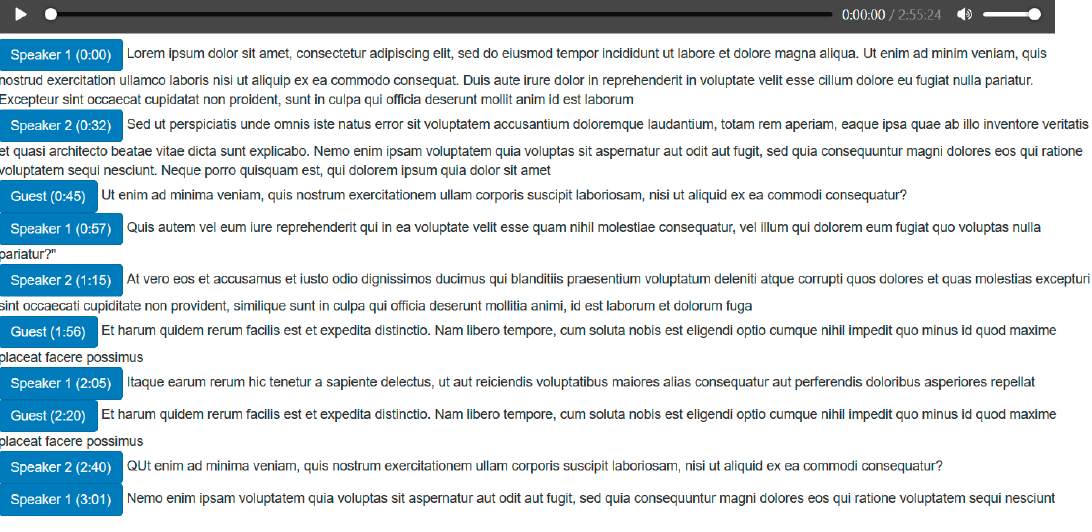
Figure 2. Interactive navigation through an annotated podcast.